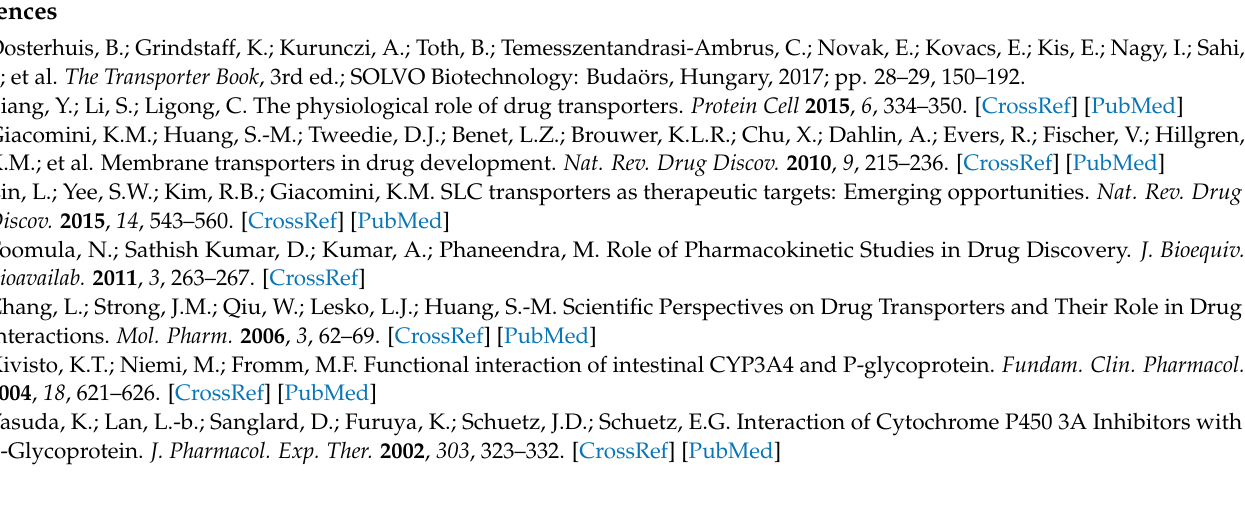
Supplementary Figure S1: Functional assays to evaluate inhibition of transporters in KO cells Supplementary Figure S2 representing changes in metabolites induced by Pgp inhibition in cells; Supplementary Figure S3 representing changes in Pgp signature metabolites and Indinavir in Caco-2 cells treated with increasing concentration of zosuquidar; Supplementary Figure S4 network analysis using Pgp signature metabolites; Supplementary Figure S5 representing changes in BCRP signature metabolites and E3S in Caco-2 cells treated with increasing concentration of the Ko143; Supplementary Figure S6 representing changes in metabolites in cells treated with MRP2 inhibitors and MRP2 KO cells; Supplementary Figure S7 representing changes in MRP2 signature metabolites and CDCF in Caco-2 cells treated with increasing concentration of MK571; Supplementary Figure S8: Data derived from publicly available database used in signature network analysis; Supplementary Figure S9: Validation of scoring system with Pgp, BCRP and MRP2 substrates; Supplementary Figure S10: Thymidylate synthase, SHMT, methionine synthase and AHCY expression in cells treated with zosuquidar (5 µ M), MK571 (200 µ M) and Ko143 (10 µ M) over 2 and 24 h and in cells with Pgp, BCRP KO and MRP2